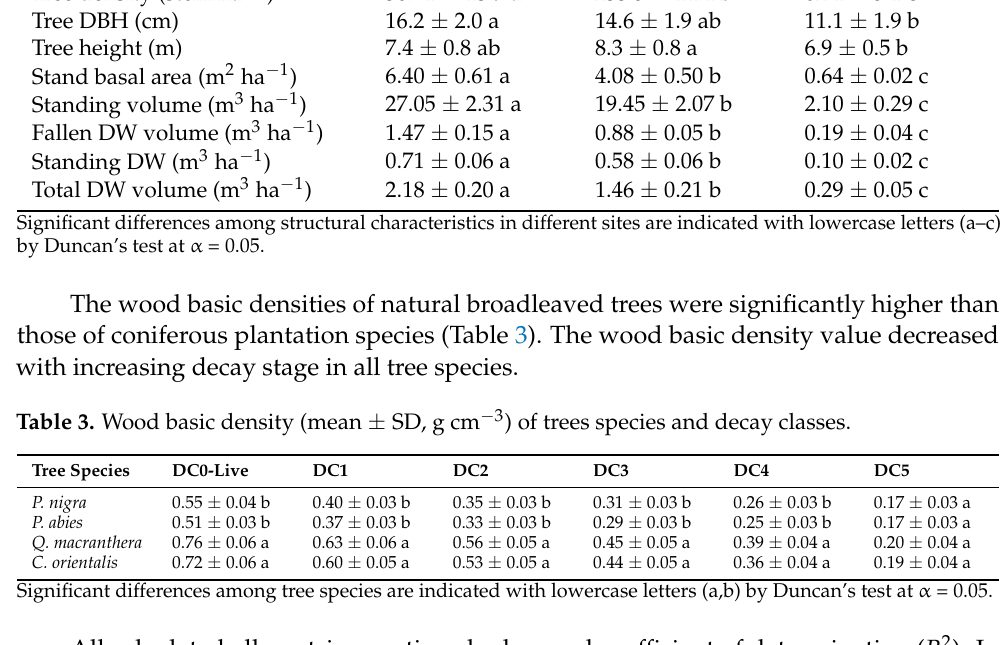
Table 2. Structural characteristics (mean ± SD) of the study stands. Parameter